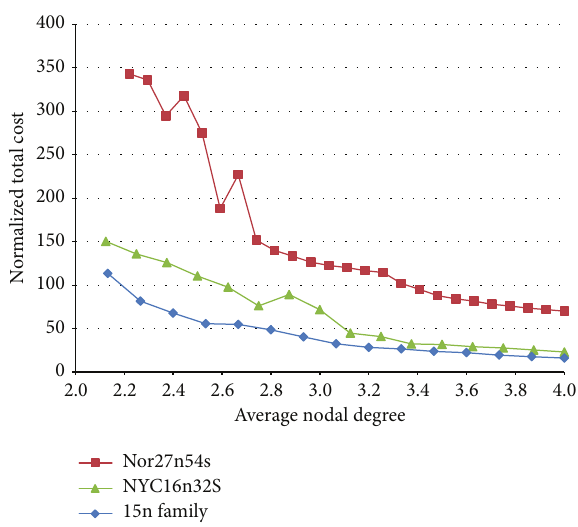
Figure 24: Normalized p -cycle restoration SCA costs for network families based on real network.